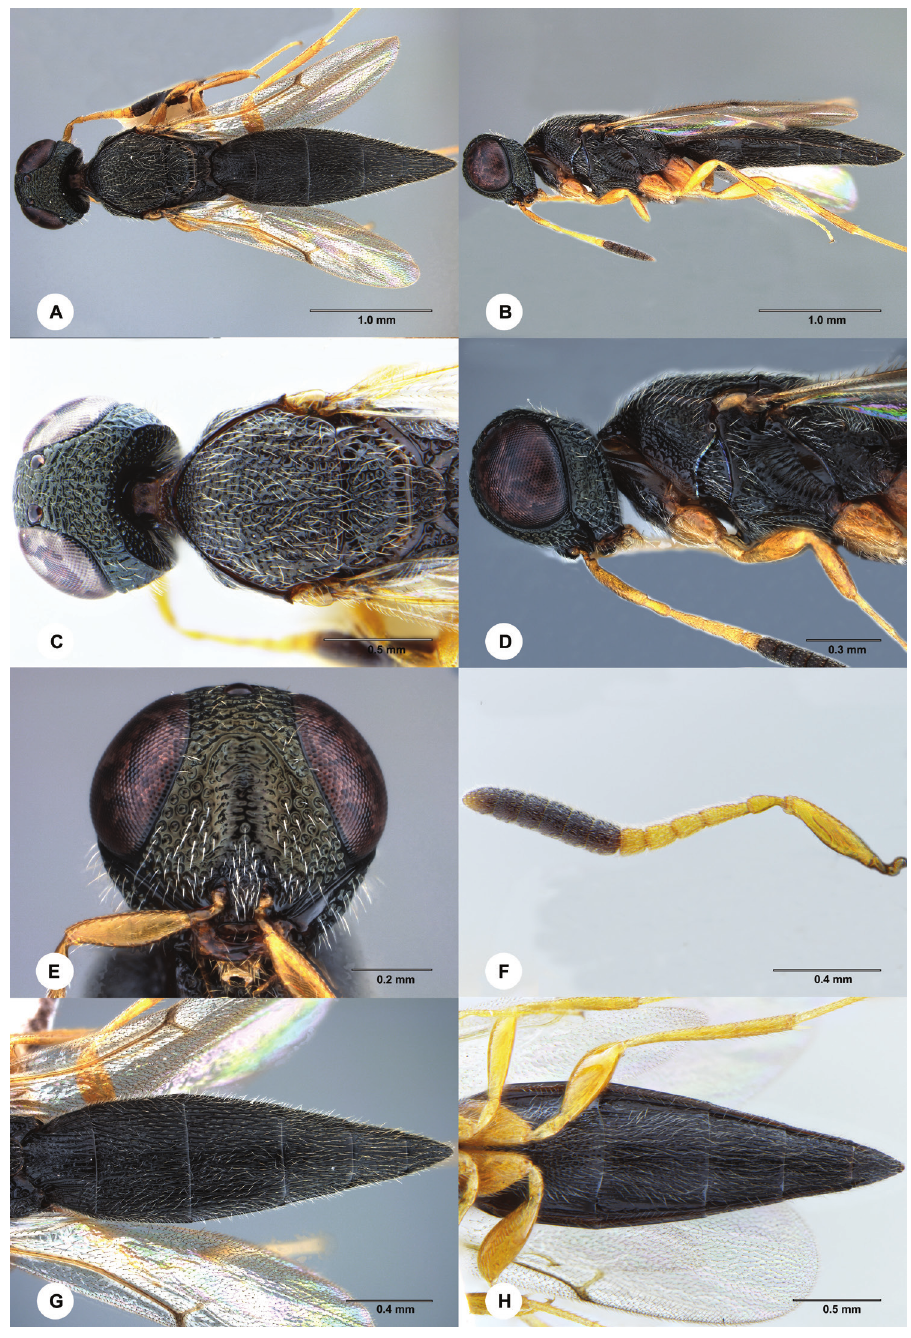
Figure 2. Oxyscelio amalocarina Mo & Chen, sp. nov., holotype, female (SCAU 3049046) A dorsal habitus B lateral habitus C head and mesosoma, dorsal view D head and mesosoma, lateral view E head, anterior view F antenna G metasoma, dorsal view H metasoma, ventral